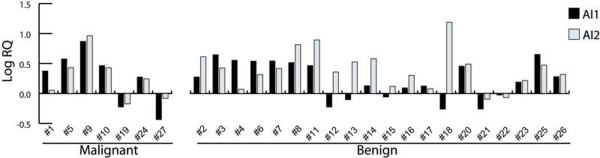
Anti-apoptotic index 1 (black bars) and 2 (white bars) in the malignant and benign salivary gland neoplasms. Most of the samples exhibited an anti-apoptotic profile. All the pleomorphic adenoma samples exhibited more BCL-2 than CASP3 transcription. Samples #19, #21 and #22, which showed a decreased AI-1 and 2, were p53 negative. X-axis represents the normal salivary glands pool of samples included as reference sample in all the reactions. AI-1 = BCL-2/BAX, AI-2 = BCL-2/CASP3.